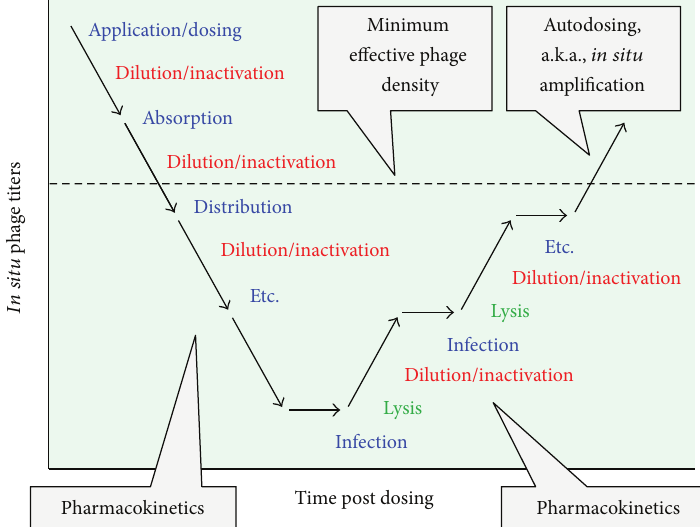
Figure 10: Time course of the pharmacokinetics of active phage therapy. Numerous pharmacokinetic processes–either through dilution, inactivation, or inefficiencies in penetration–have the effect of reducing phage densities in situ such as below minimum effective phage densities (MEPDs). These losses may be minimized by reducing the length of the chain of processes separating phage application from phage contact with target bacteria or instead can be addressed by supplying more phages, such as to counteract inevitable losses. Metabolism as a pharmacokinetic process, in the form of phage replication and therefore in situ amplification in density (auto dosing), can reverse these losses and allow an achievement of MEPDs, at least local to target bacteria. The process illustrated in the figure is an elaboration on the concept that otherwise has been described as active treatment, that is, supplying insufficient phage numbers through traditional dosing to achieve MEPDs, and thus relying on active phage replication instead to achieve these